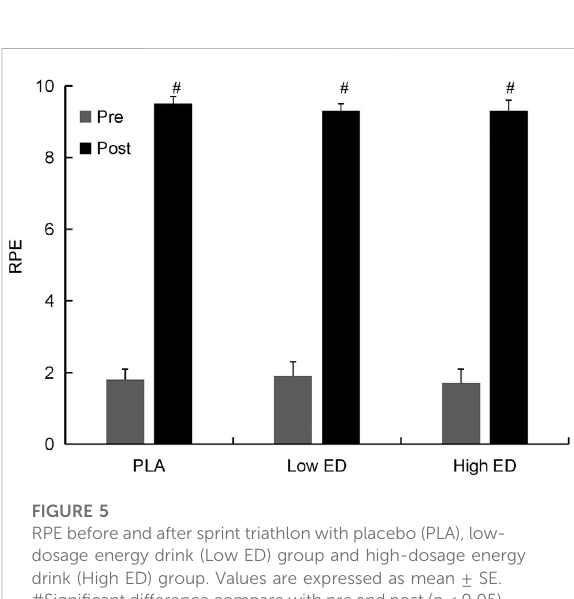
FIGURE 5 RPE before and after sprint triathlon with placebo (PLA), low- dosage energy drink (Low ED) group and high-dosage energy drink (High ED) group. Values are expressed as mean ± SE. #Signi fi cant difference compare with pre and post ( p < 0.05). Values are expressed as mean ±